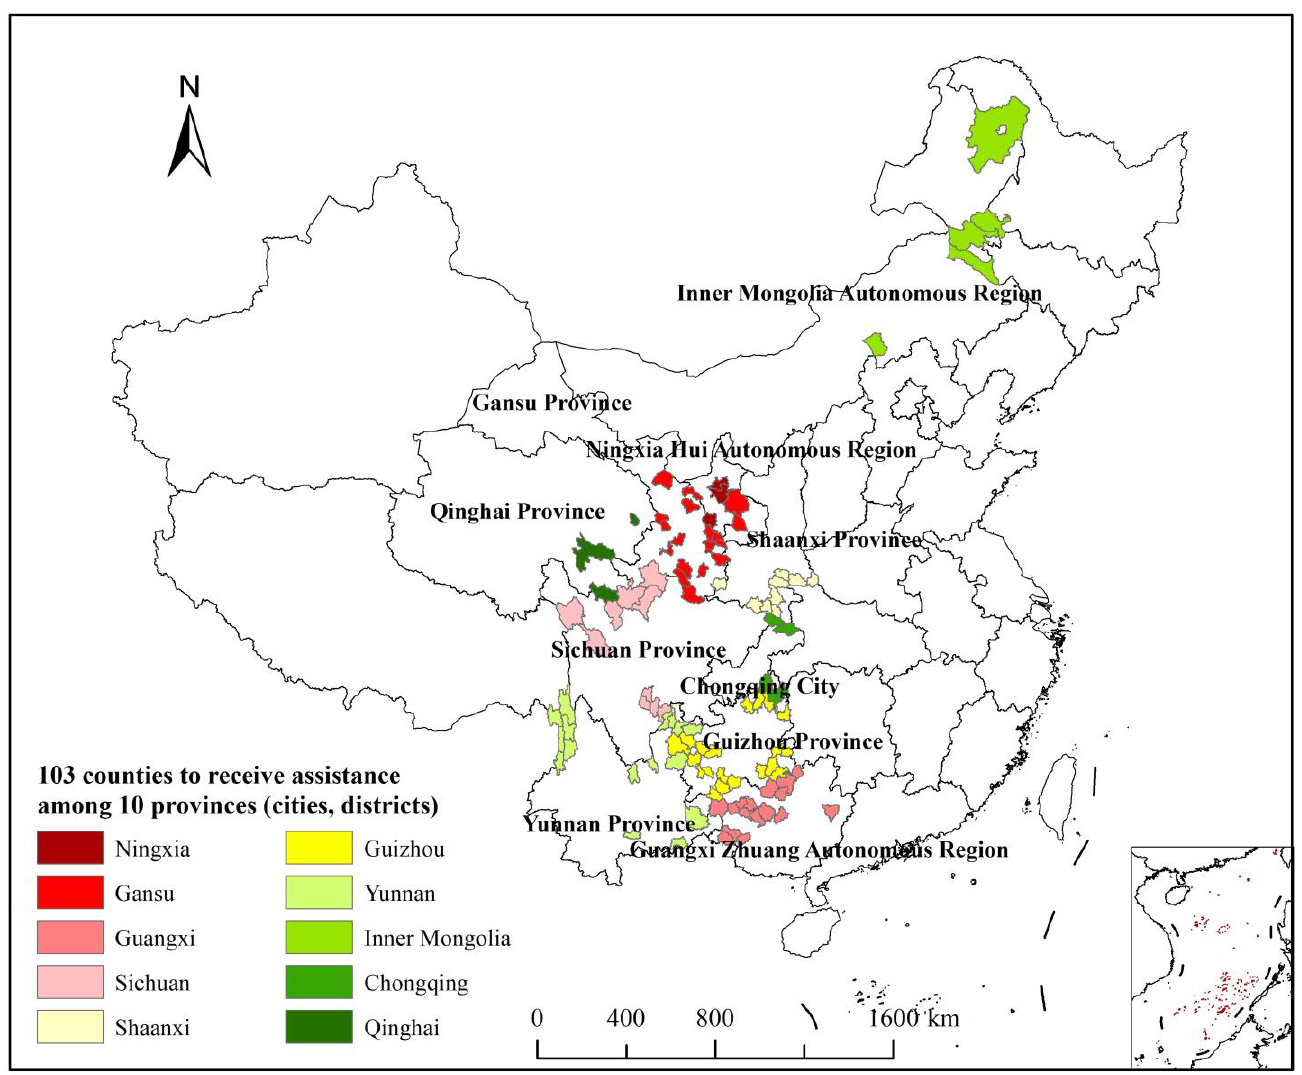
Figure 1. Study areas.